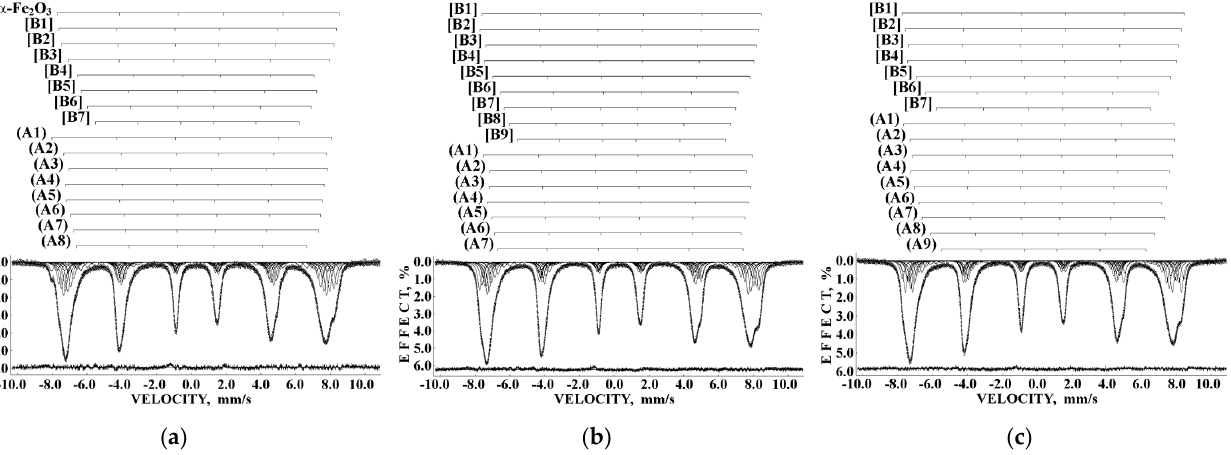
Figure 69. Room temperature Mössbauer spectra of MgFe 2 O 4 nanoparticles in samples MFO1 ( a ), MFO2 ( b ) and MFO3 ( c ) measured with a high velocity resolution. Indicated components are the results of the best fits. The differential spectra are shown on the bottom. Adapted from Ref. [94] with permission from Elsevier: Journal of Alloys and Compounds, Vol. 912, Ushakov M.V., Nithya